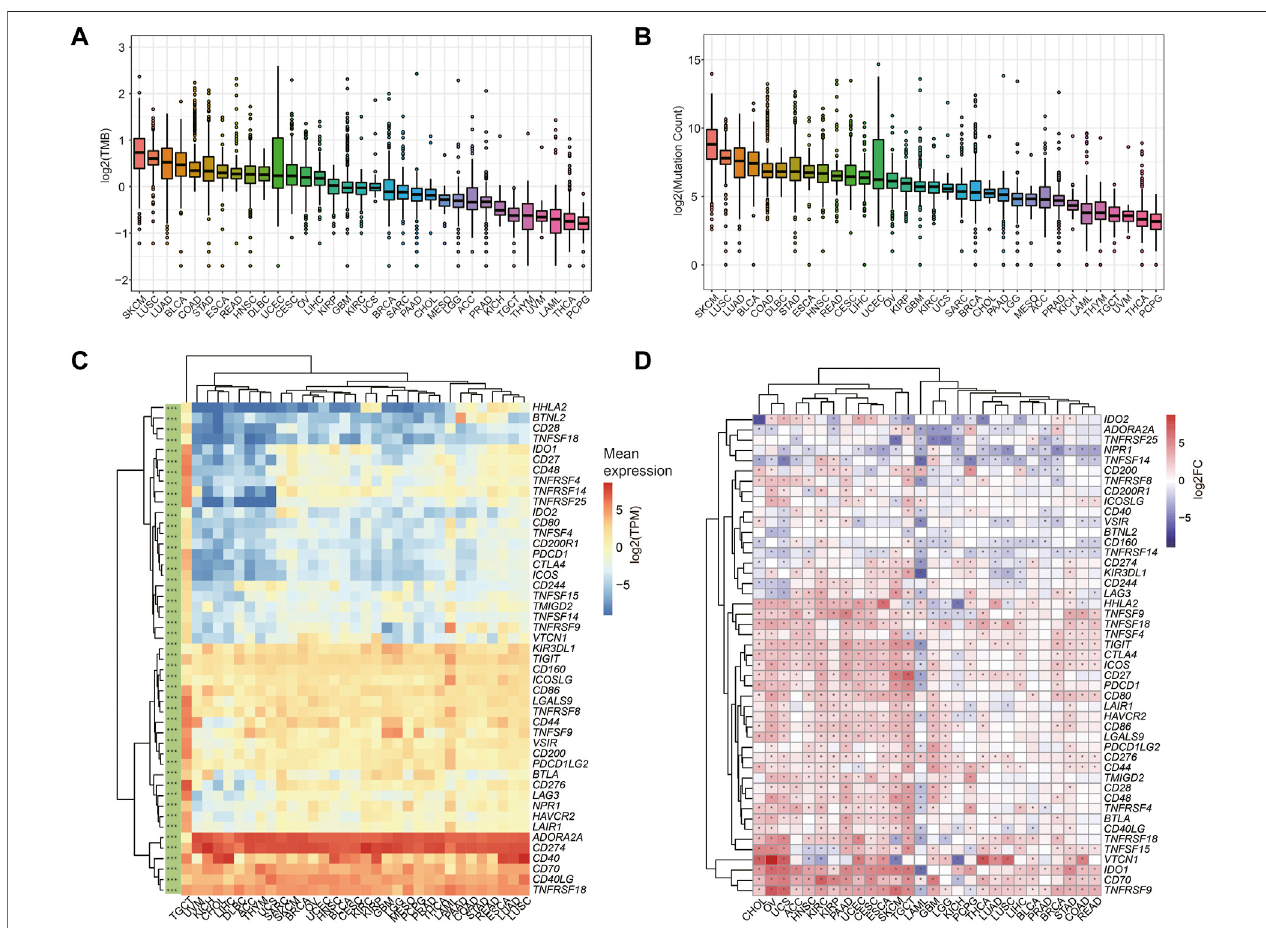
FIGURE 5 | The prediction of immunotherapy sensitivity. (A – B) Tumor mutational burden (TMB) (A) and mutation count (B) across 33 cancer types. (C) Gene expression pro fi ling of ICGs in different tumors in the TCGA cohort (* represents that ICGs are signi fi cantly differentially expressed in different tumors, Kruskal-Wallis test was used, and *** means p < 0.0001). (D) Differential expression of ICGs constructed in 28 TCGA cancers with tumor-normal paired samples (* indicates ICGs are differentially expressed in tumor and normal tissues).